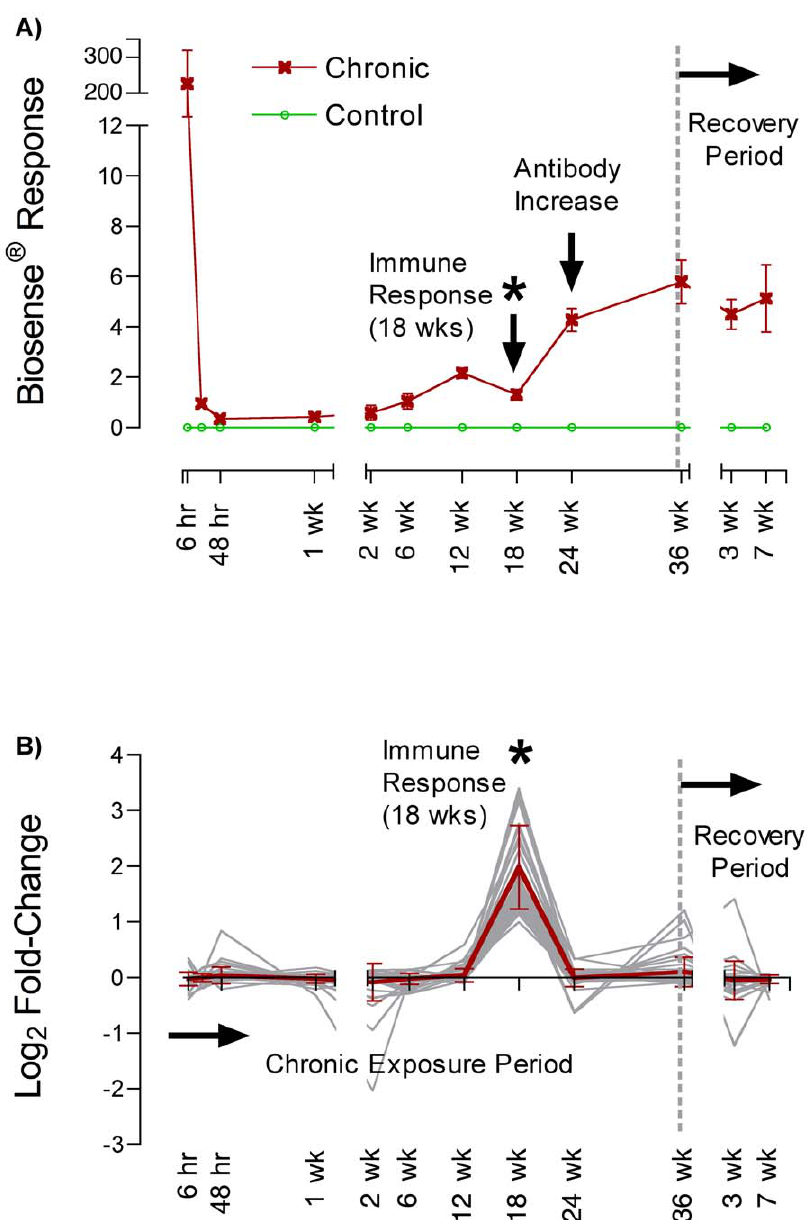
Figure 1. A) Response of Biosense H (Bergen, Norway) competitive enzyme-linked immunosorbent assays (ELISAs) in serum of exposed and time-matched control zebrafish ( Daniorerio ) at all sampling time points. Detection by competitive ELISA indicates the presence of DA and/or DA-specific antibodies in serum. B ) One K-means cluster for a set of significantly differentially expressed genes (1.5 fold; p , 0.05) quantified in whole brains from exposed and control zebrafish. The y-axis represents the log 2 fold-change for genes in this cluster at all sampling time points (x-axis). The K-means algorithm forces all differentially expressed genes into clusters or groups with other genes that behave most similarly over all time points. Once clusters have been formed, further analysis of the known functions of the genes within each cluster can be used to identify potentially impacted biological processes. Functional annotation clustering using DAVID (http://david.abcc.ncifcrf.gov/) of the genes shown here identified Immune Function as the major functional group (enrichment score: 1.98). Up regulation of immune related genes at 18-weeks (demarked by *) indicates a significant immune response, after which antibody levels appear to rise in the blood (Figure 1A). doi:10.1371/journal.pone.0036213.g001 cluster dominated by immune function genes (DAVID; http:// david.abcc.ncifcrf.gov/; enrichment score: 1.98) that were signif- icantly upregulated at 18 weeks, just before the apparent increase in DA specific antibody titer in serum (Figure 1B). Gene Ontology MHC class IIA and B, and an MHC class I gene) displaying (GO) terms for Biological Process represented in the annotation significant upregulation by microarray analyses and present in the clusters included ‘‘antigen processing and presentation’’, ‘‘MHC K-means cluster shown in Figure 1B were further validated by protein complex’’ and ‘‘immune response’’.